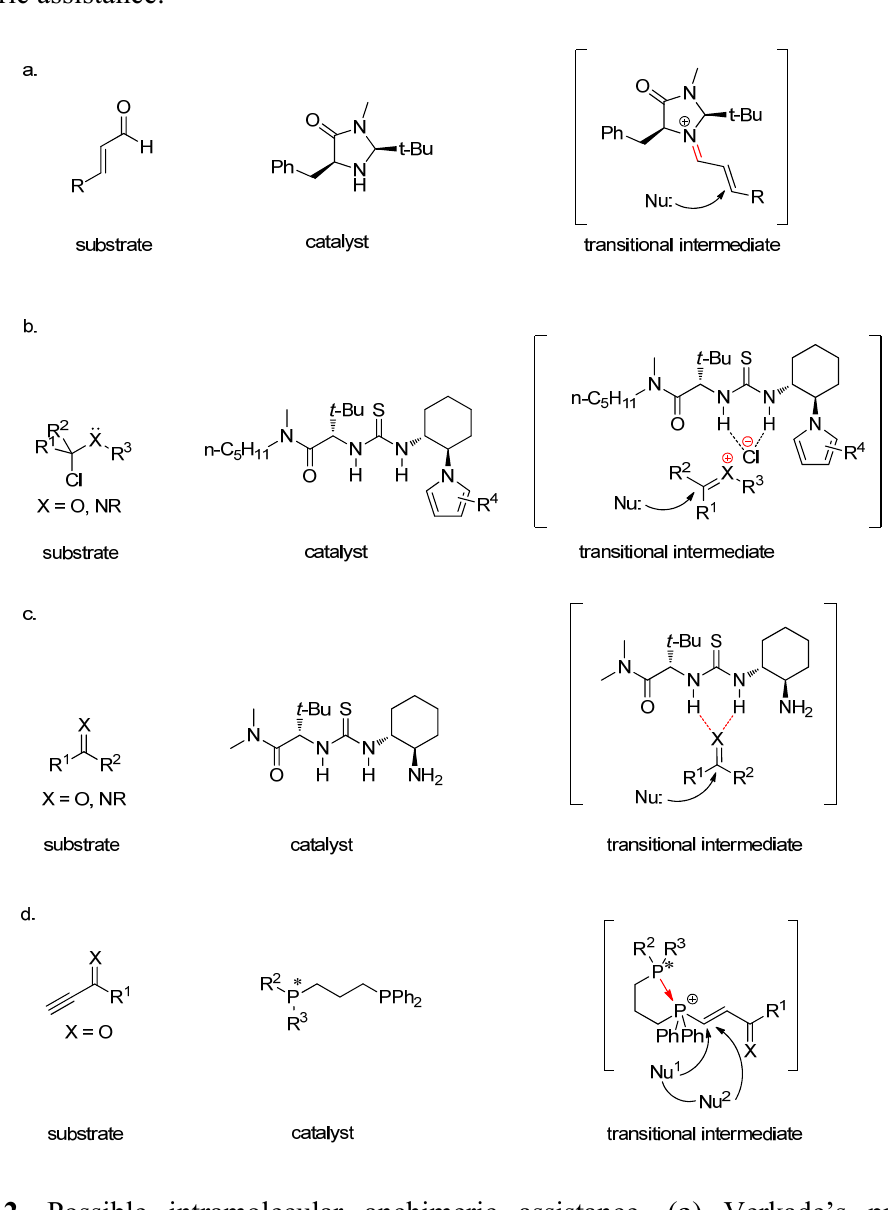
Figure 1. Modes of enantioselective induction provided by organocatalysts through ( a ) covalent bonding; ( b ) ionic bonding; ( c ) hydrogen bonding; and ( d ) intramolecular anchimeric assistance.